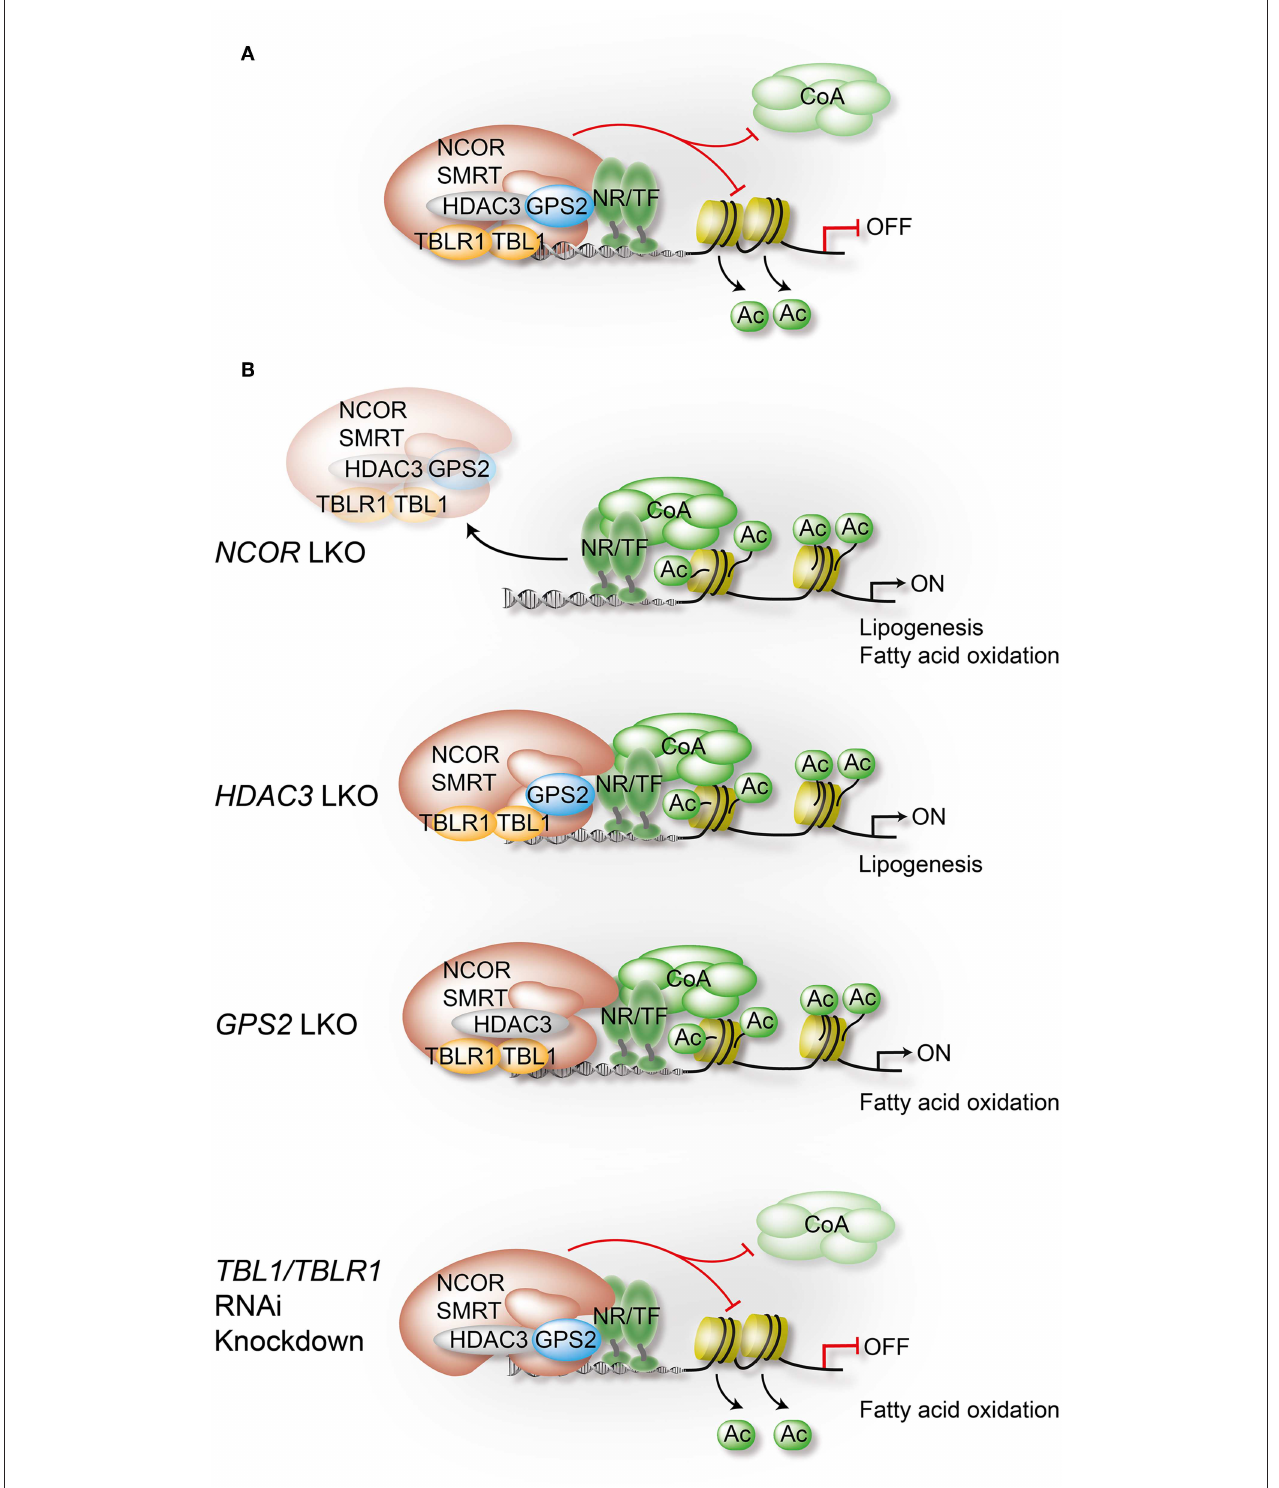
FIGURE 3 | Liver-specific depletion of individual co-repressor complex subunits reveals overlapping yet non-redundant roles. In hepatocytes, NCOR, to a lesser extent SMRT, and GPS2 directly interact with TFs, including metabolite-sensing NRs and inflammatory TFs. TBL1/TBLR1 may stabilize chromatin recruitment of the